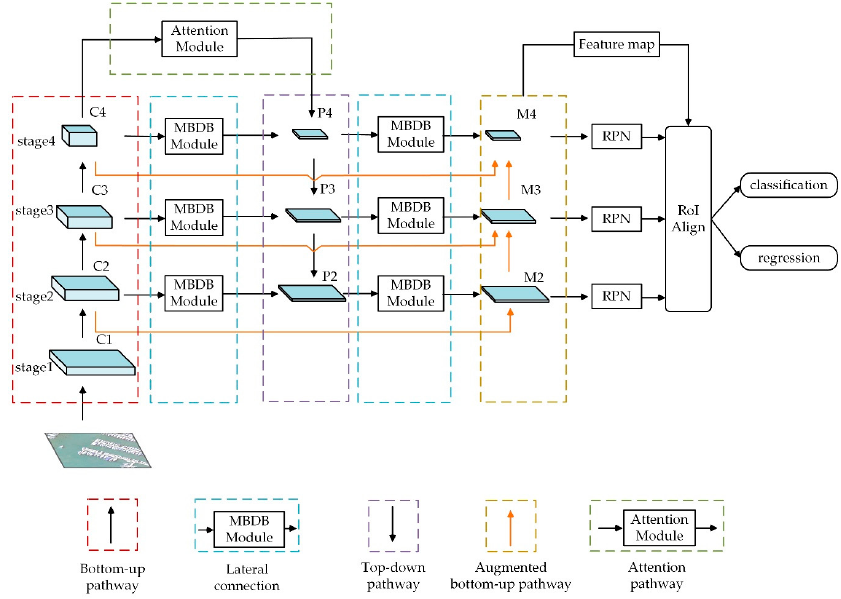
Figure 2. Architecture of the proposed Extended Feature Pyramid Network (EFPN). RPN: region